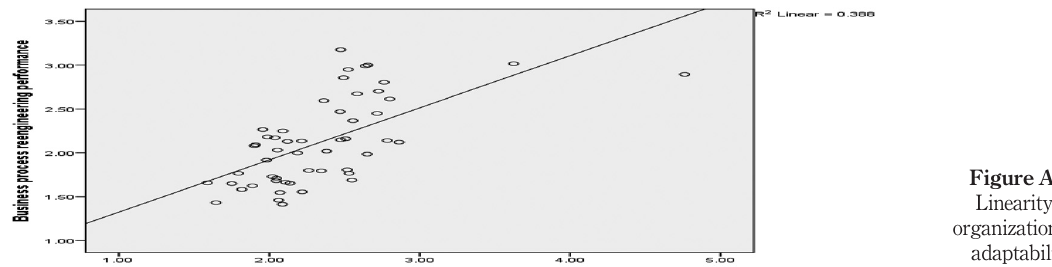
Figure A5. Linearity of